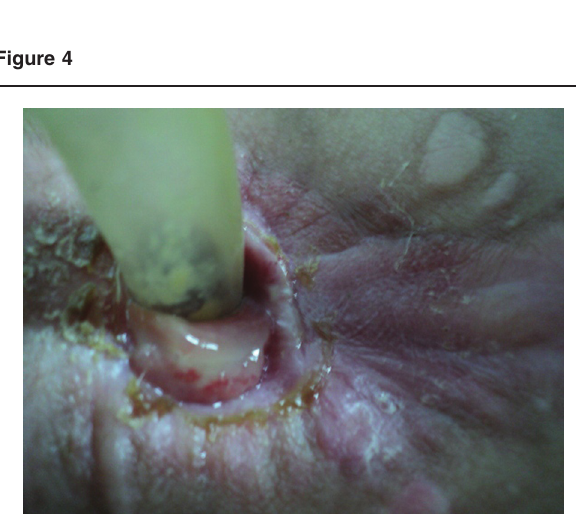
External view showing granulations around the stoma and hypertro- phic scar.